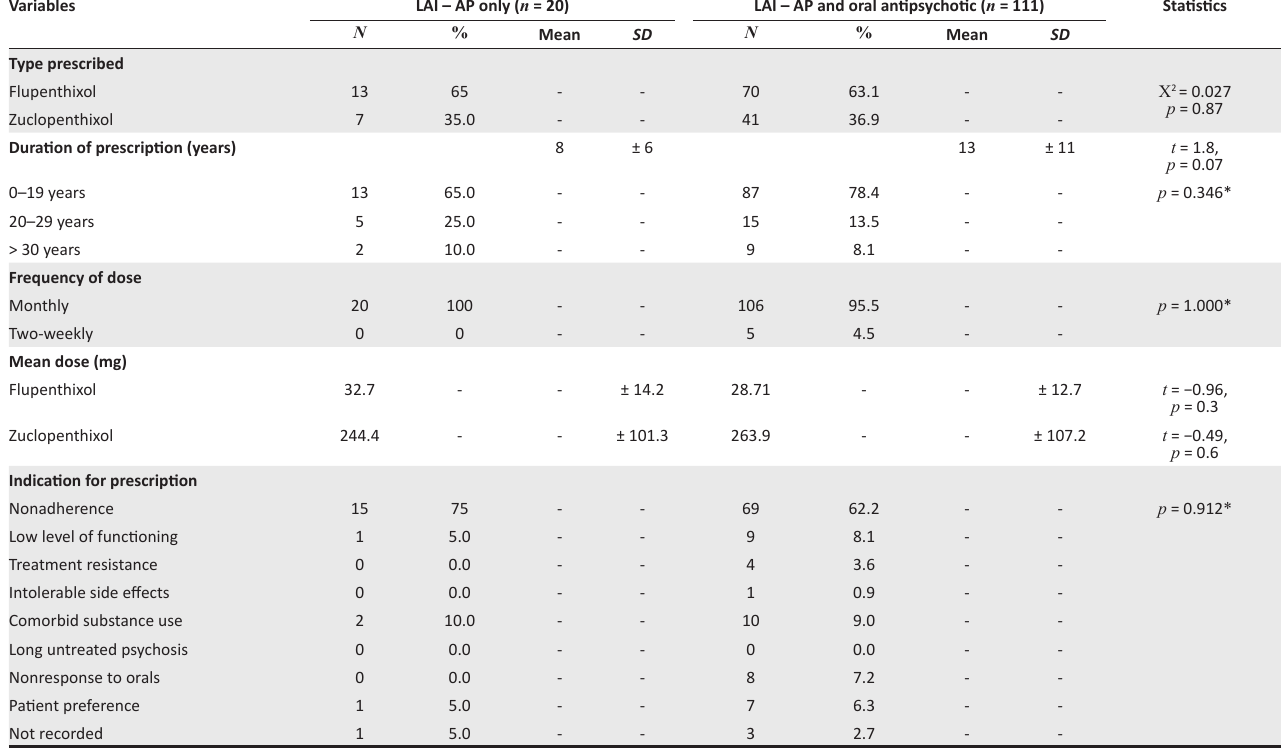
TABLE 5: Frequency distribution of the treatment characteristics in the group of patients on long-acting injectable antipsychotics (LAI – APs) only compared with the group on LAI – APs combined with oral antipsychotics. Variables LAI – AP only ( n = 20) LAI – AP and oral antipsychotic ( n =